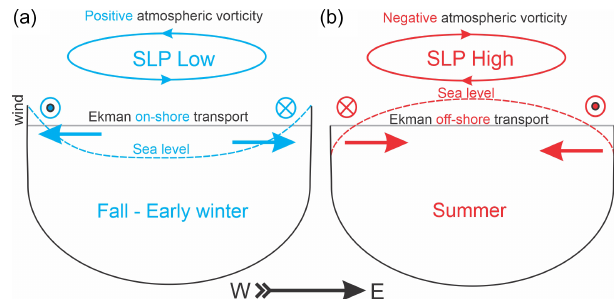
Figure 11. Diagram of the proposed impact of the seasonal changes in atmospheric vorticity on the sea-level seasonal variability in Hud- son Bay. (a) Positive (cyclonic) vorticity during October–December causes onshore Ekman transport and storm surges over the coast. (b) Negative (anticyclonic) vorticity during June–July forces off- shore Ekman transport. During winter, a complete sea-ice cover re- duces momentum transfer from wind stress to the water column di- minishing impact of atmospheric forcing on sea-level variability. Dotted and crossed circles depict northerly and southerly along- shore surface winds,